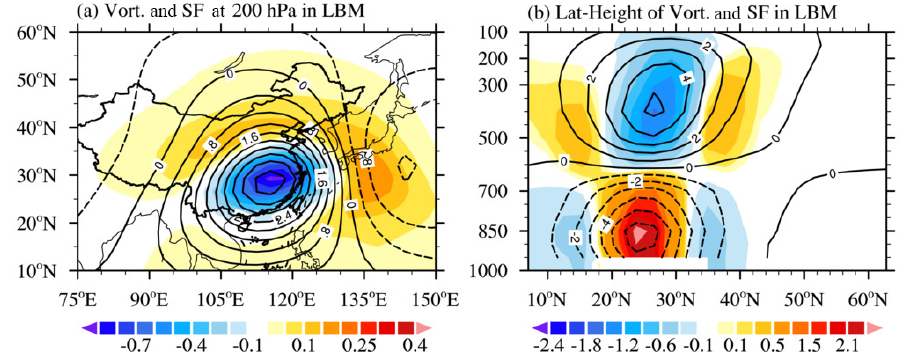
Figure 11. (a) Horizontal distribution of stream function (contours, unit: 10 6 m 2 s − 1 ) and relative vorticity (shading, unit: 10 − 6 m 2 s − 1 ) at 200hPa in the LBM. (b) Latitude–height cross section of the stream function (contour, unit: 10 6 m 2 s − 1 ) and relative vorticity (shading, unit: